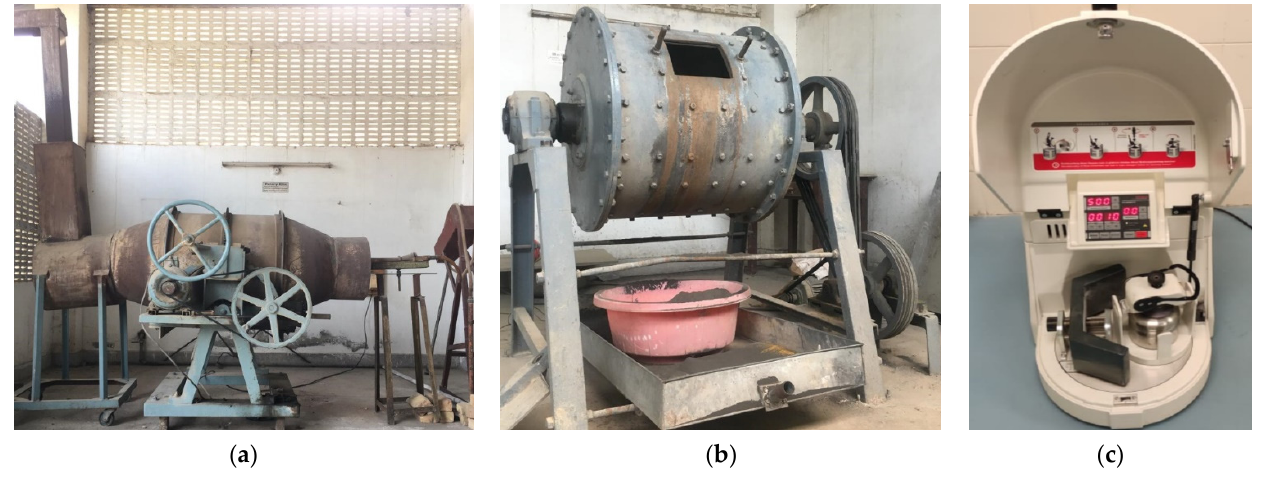
Figure 1. ( a ) Burning of WSA in a rotary kiln at 500 °C for 4 h, ( b ) rotary ball mill used in WSA grinding to obtain F-WSA, and ( c ) Planetary Mono Mill PULVERISETTE 6 used in F-WSA grinding to obtain SF-WSA.